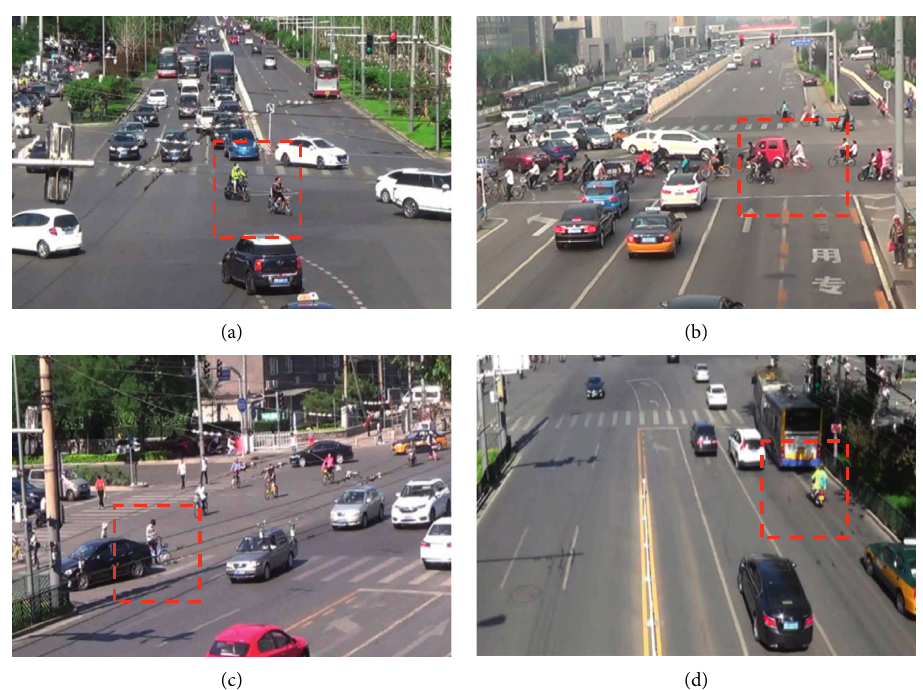
Figure 1: Violations at signalized intersections under mixed traffic in Beijing. (a) Crossing the intersection diagonally. (b) Running the red light. (c) Waiting in front of the motorway. (d) Intruding into the